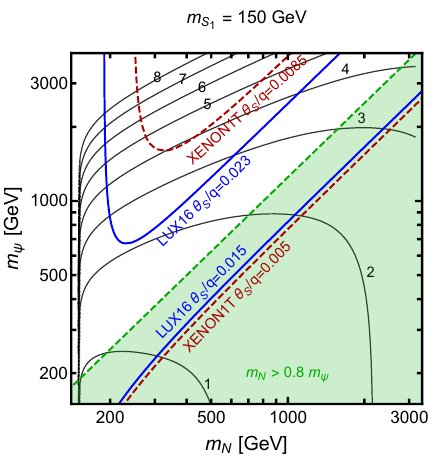
Figure 1 . The coupling y S required to obtain the observed relic density in Scenario 1A, for m S = 150 GeV and q (cid:29) 1. We also show direct-detection limits (blue, continuous) and future 1 prospects (red, dashed), from LUX 2016 and XENON1T, respectively. For a (cid:12)xed value of (cid:18) S =q , the excluded (probed) region is below the blue (red)